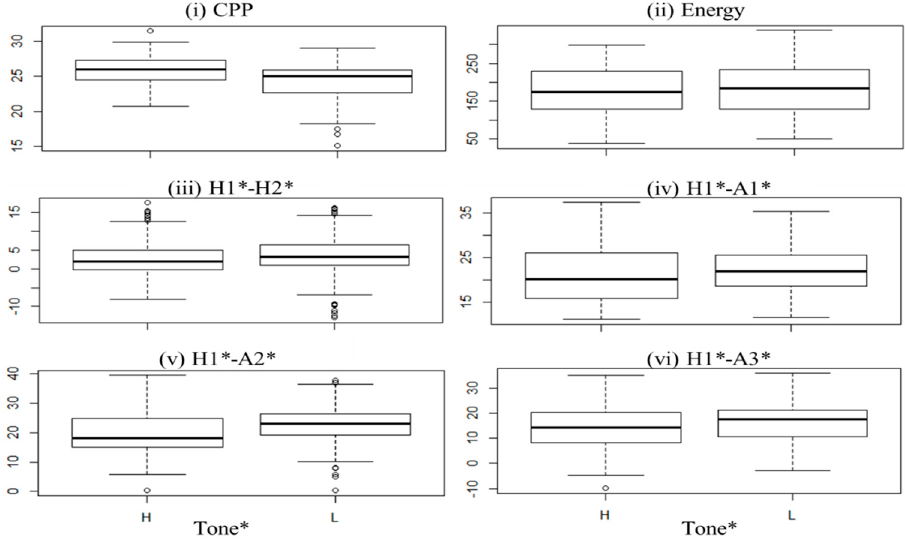
Figure 3. Box plots representing the mean values for each parameter: ( i ) CPP, ( ii ) Energy, ( iii ) H1*– H2*, ( iv ) H1*–A1*, ( v ) H1*–A2*, and ( vi ) H1*–A3*. Tone* indicates significant interactions in